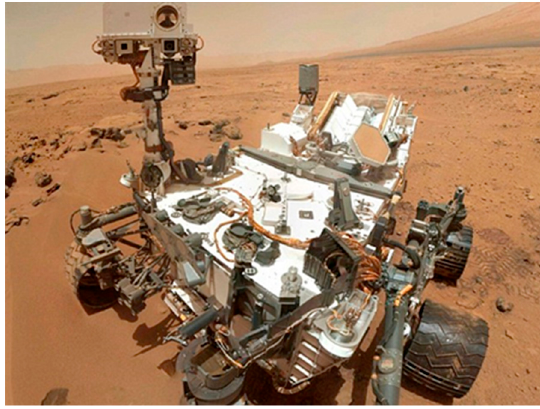
Figure 2. NASA’s Mars Science Laboratory—Curiosity.